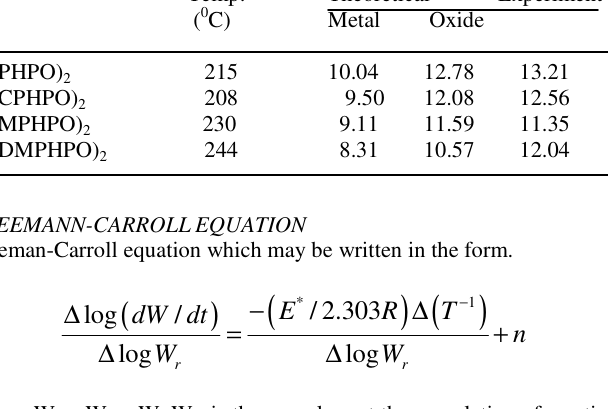
Table 2. Thermal decomposition data